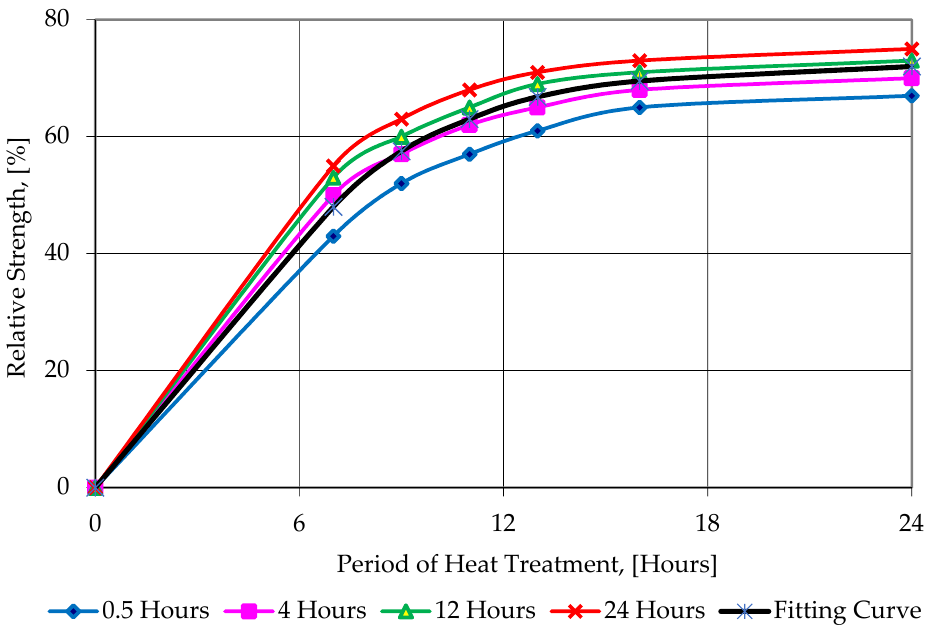
Figure 6. Changes in the relative strength of heat-treated BF-reinforced ECC depending on the period of